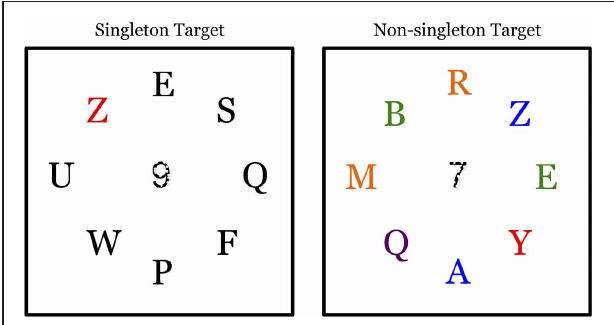
FIGURE 1 | In both conditions, participants indicated the presence or absence of a red letter. In the singleton-target condition, all remaining letters were colored white on a black background (black and white are reversed in the figures for clarity). In the non-singleton-target condition, the remaining letters were heterogeneously colored. The display was on for